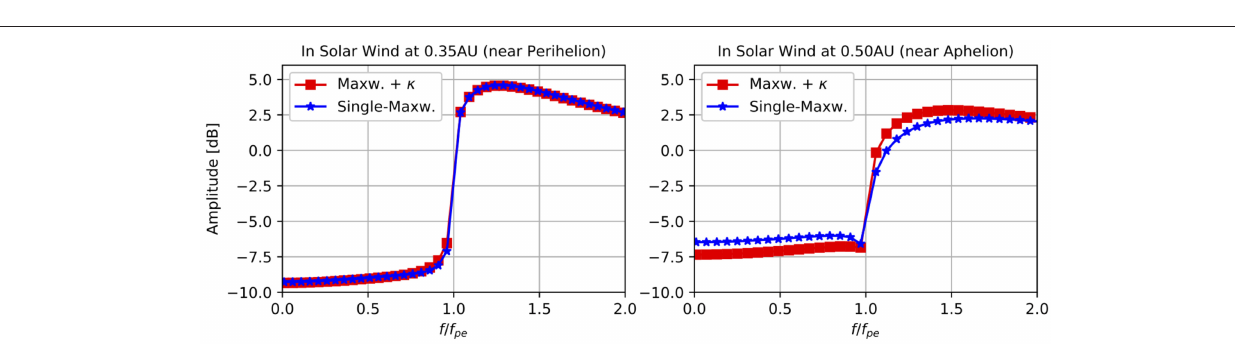
6.89 with λ D , halo = 46.37 m, λ D , core = 5.24 m (Pierrard et al., 2016). The modeled spectra is shown in Figure 9 (right